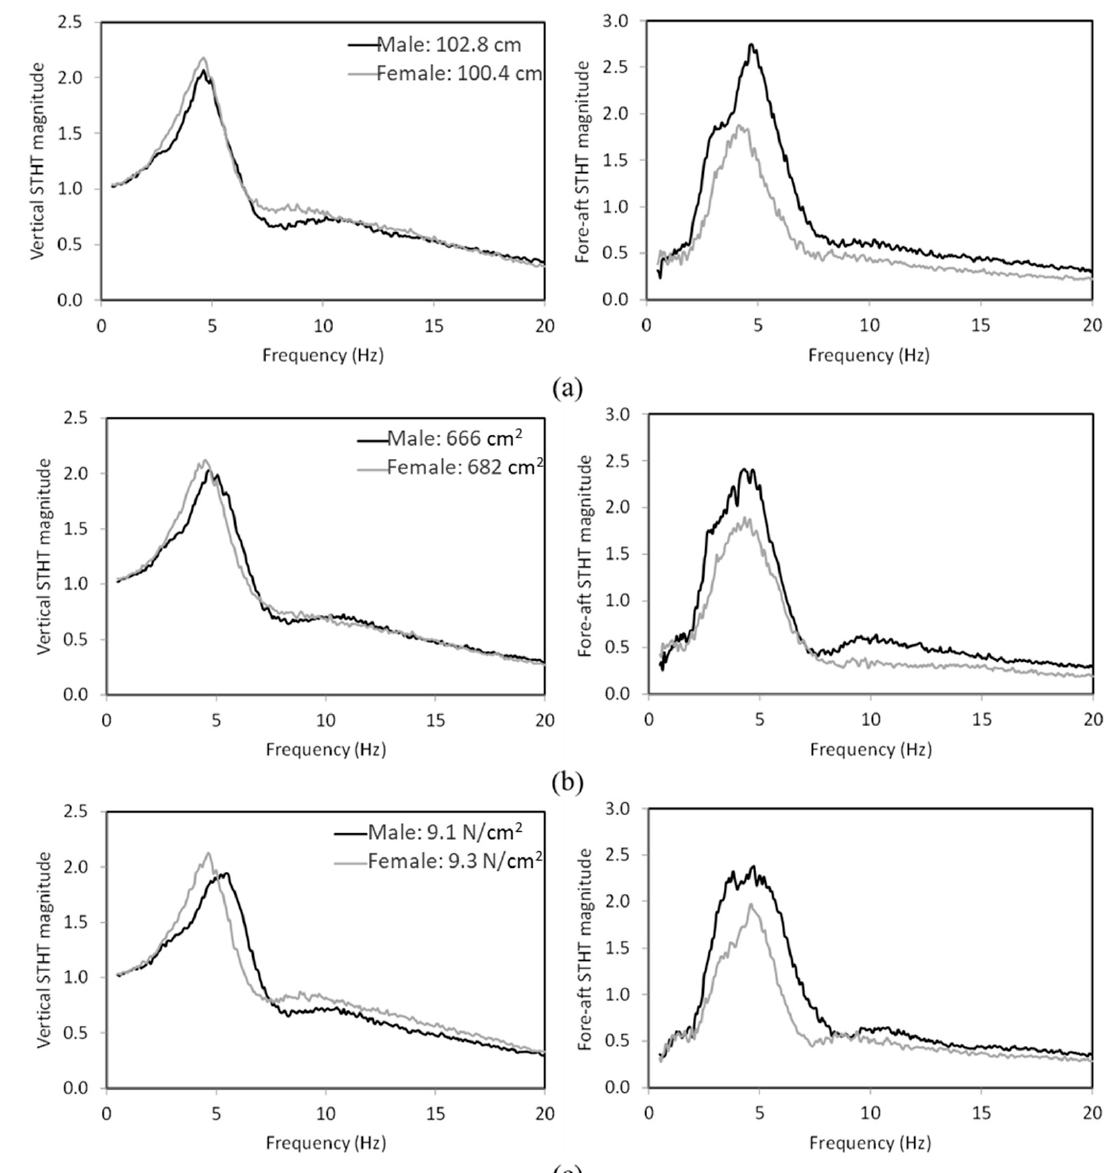
Figure 14. Effect of gender on mean STHT vertical and fore-aft magnitude responses considering comparable build-related parameters: ( a ) hip circumference; ( b ) seat–pan contact area; and ( c ) mean contact pressure (NB support, 0.50 m/s 2 excitation).